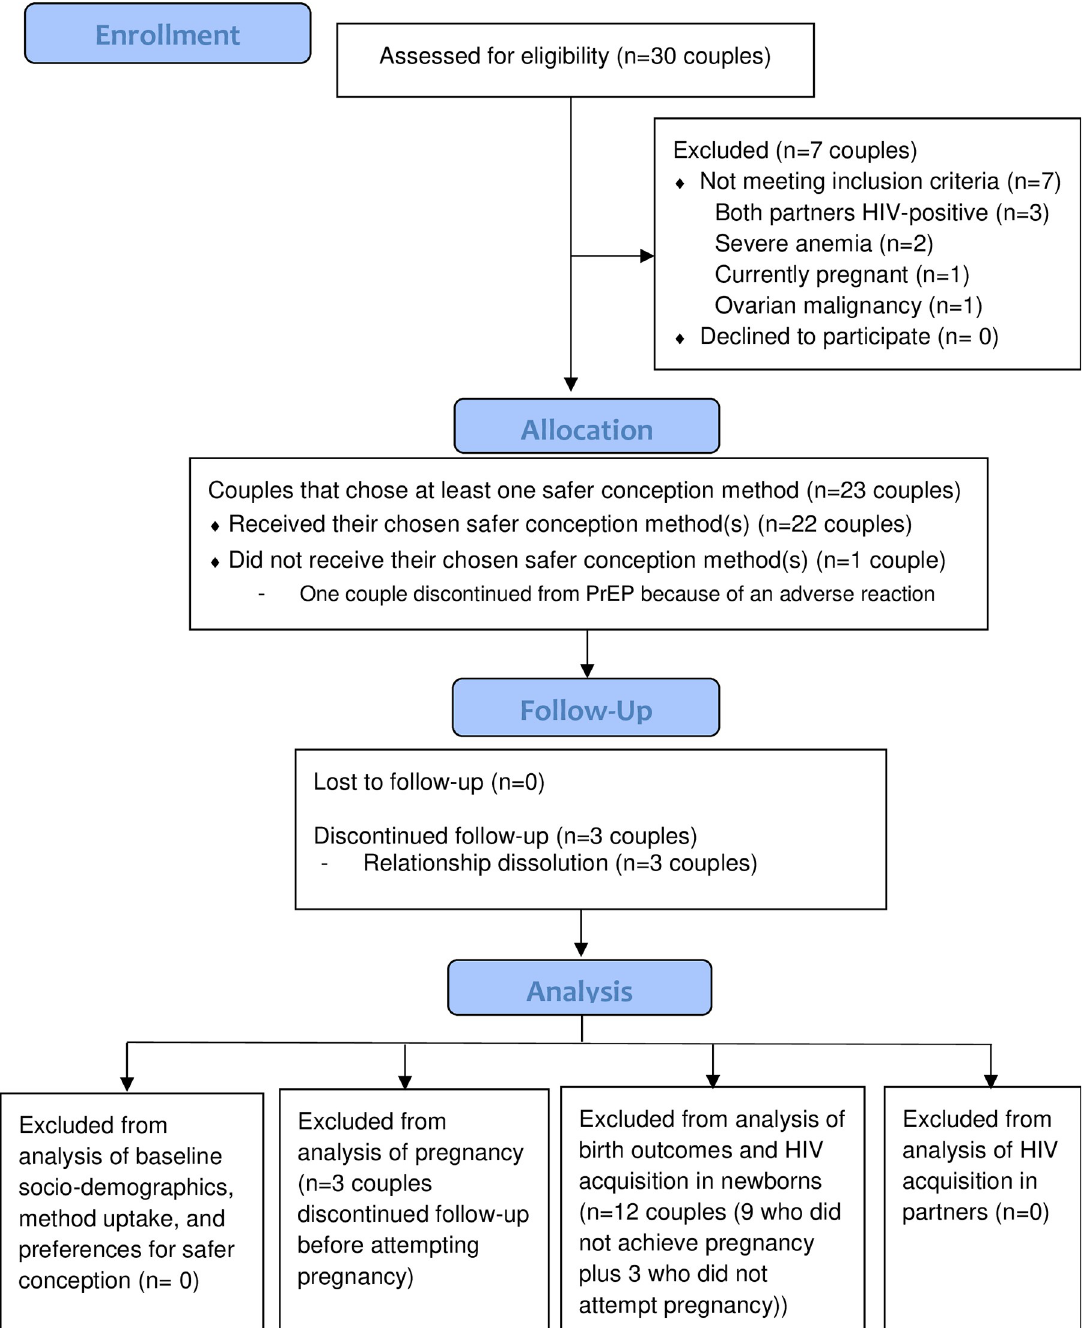
Fig 6. Enrollment and follow-up of